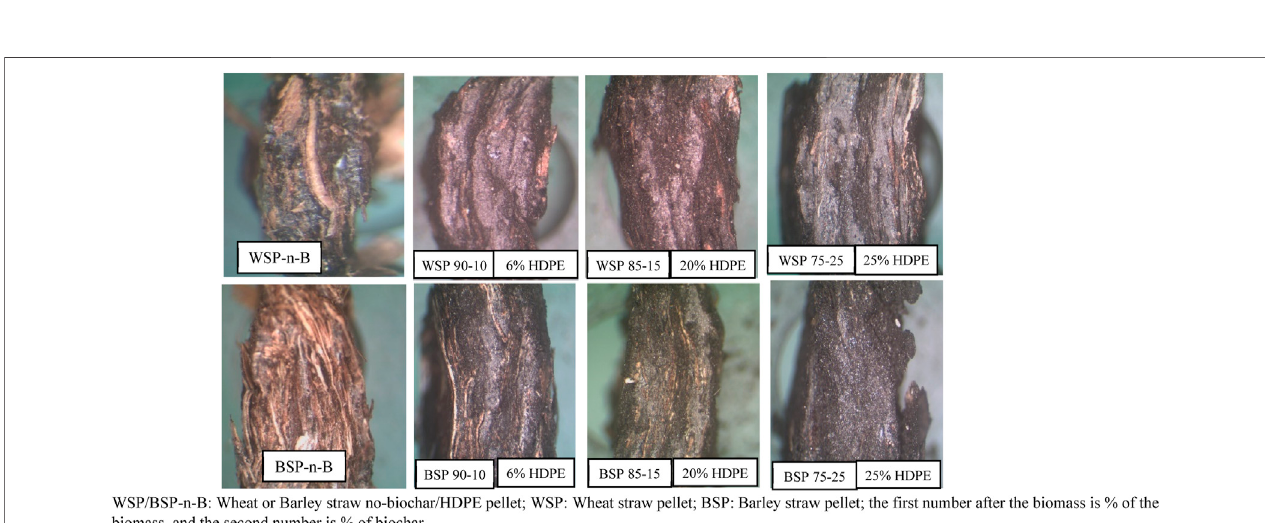
FIGURE 10 | Cross-sectional surface of microwave-torre fi ed wheat and barley straw pellets with biochar-HDPE blend at × 16 magni fi cation.